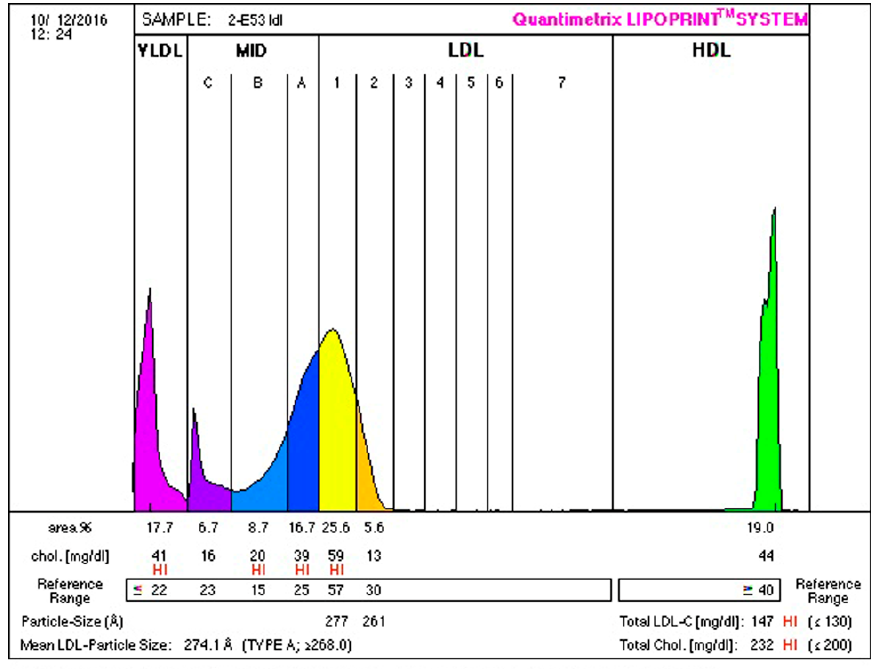
Figure 4. LDL ‐ C separation after therapy, indicating 17.7% of VLDL (purple), 32.1% of IDL (blue), 31.2% of large (yellow and orange), 0.0% of small (red) LDL sub ‐ fractions, and 19.0% of HDL sub ‐ fractions.